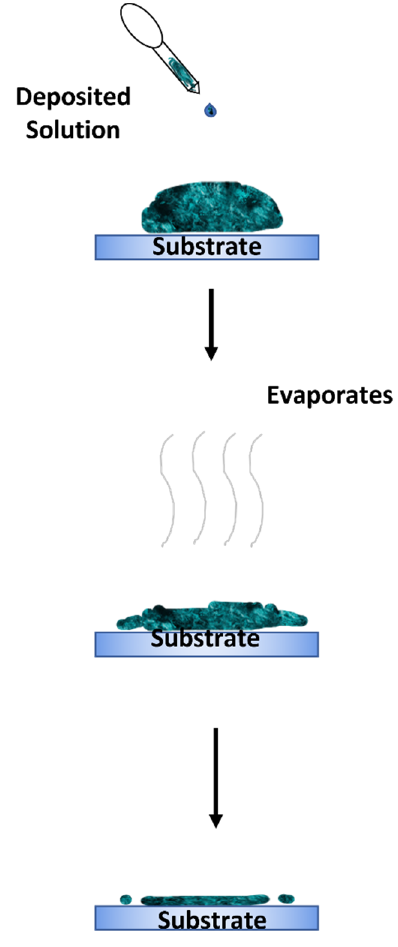
Figure 18. Drop casting method.